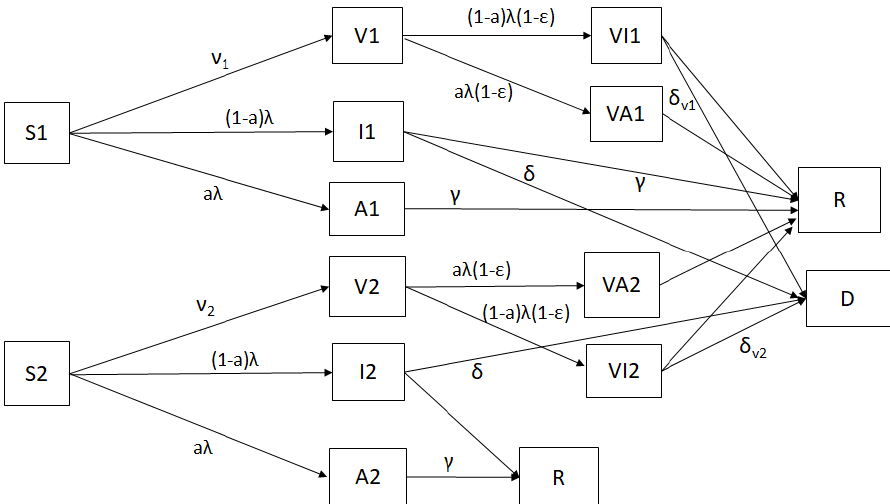
Figure 1. Diagram for the COVID-19 mathematical model including a vaccination program (1). The boxes represent the different classes and the arrows the transitions between these